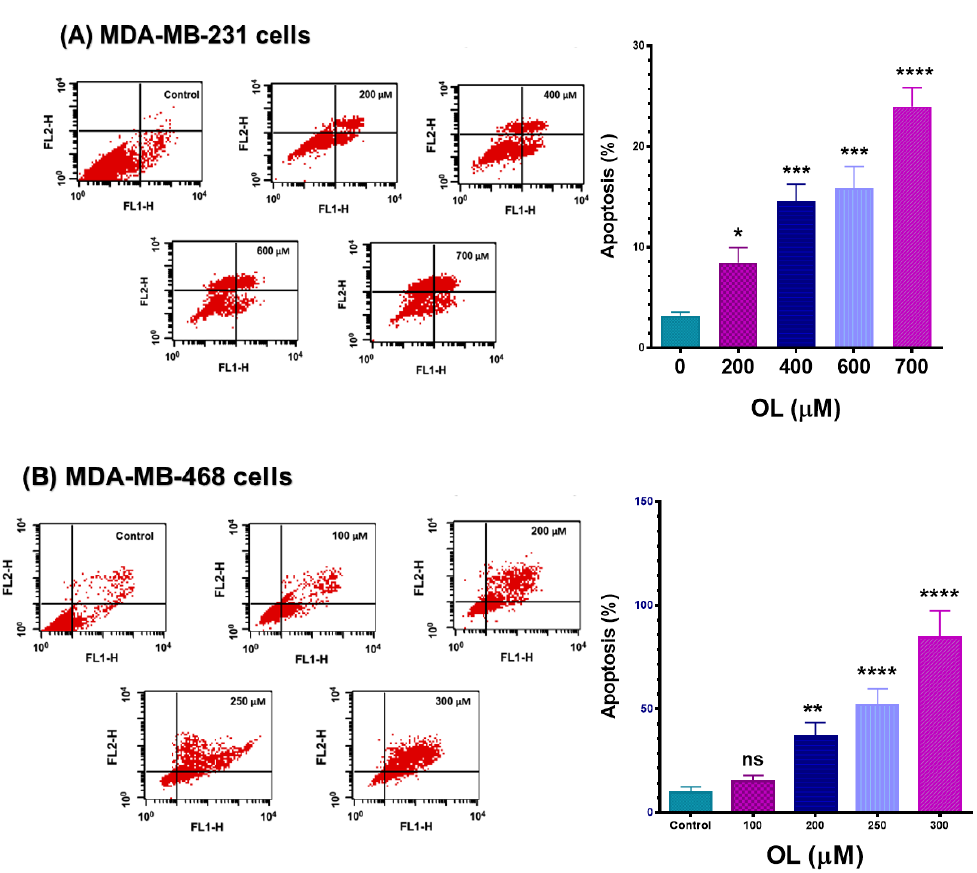
Figure 4. Apoptotic e ff ects of oleuropein (OL) in ( A ) MDA-MB-231 and ( B ) MDA-MB-468 TNBC cell lines. TNBC cells were exposed to OL for 48 h at concentrations ranging from 0 to 700 µ M in MDA-MB-231 cells and 0–300 µ M in MDA-MB-468 cells, while untreated control cells were incubated only with experimental media. Treated and control cells were labeled using an Annexin-V-FITC apoptosis kit. The percentage of apoptotic and necrotic cells in each sample was analyzed using CellQuest software. Each data point in the bar graphs represents the mean ± combined percentage of early and late apoptotic cells and the SEM of two independent studies with n = 3 each. The significance of the di ff erence between each treatment vs. control was calculated using one-way ANOVA, followed by Bonferroni’s multiple comparisons test. * p < 0.05, ** p < 0.01, *** p < 0.001, and **** p < 0.0001 indicated the statistically significant di ff erence. ns, nonsignificant. FL1-H, Annexin V-FITC, and FL2-H, propidium